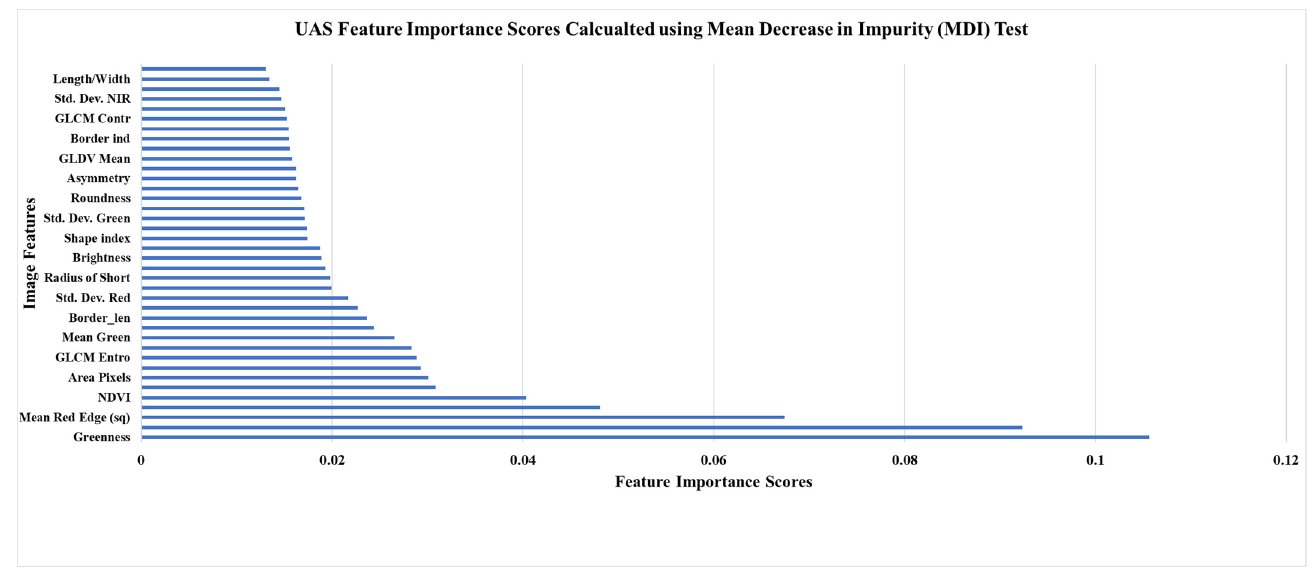
Figure 3. UAS classification feature importance scores calculated using the MDI test. Table 5. Forest health thematic map accuracy assessment error matrix produced using the UAS imagery, random forest (RF) classifier, and feature reduction digital classification method. The classes represented in this error matrix include: coniferous (C), deciduous (D), coniferous stressed (CS), deciduous stressed (DS), and dead/degraded